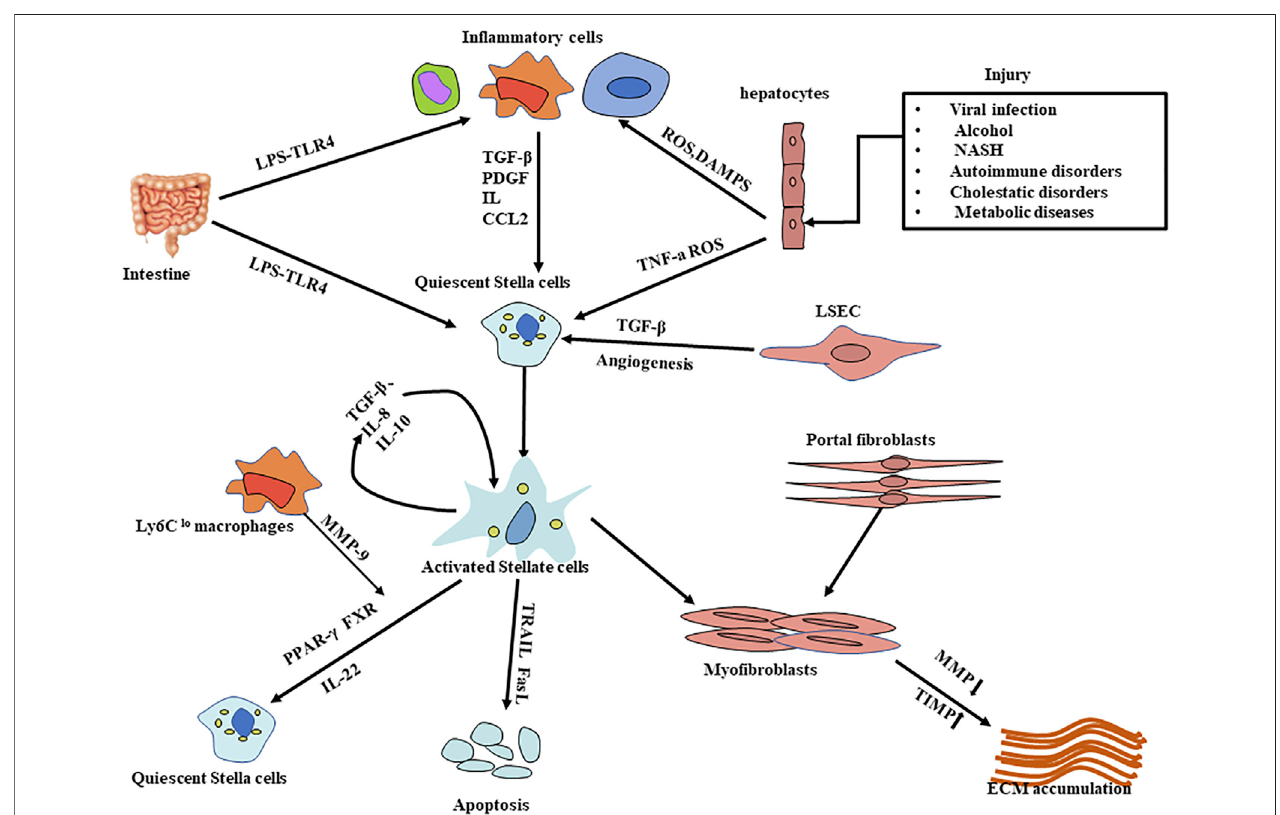
FIGURE1| Mechanismsofliver fi brosis.LiverinjuryiscausedbyavarietyofstimulithatresultinhepatocytedamageandthereleaseofsubstancessuchasROS;in response to persistent hepatocyte injury, HSCs and macrophages (including Kupffer cells) are activated, activated myo fi broblasts increase and excessive ECM is produced, leading to the progression of liver fi brosis. The activation of hepatic stellate cells is a key step in the process of liver fi brosis. Many in fl uential factors regulating HSC activation, proliferation, function, and survival have emerged as important therapeutic targets; likewise, protection of hepatocytes from damage and degradation of excessive ECM deposition provide therapeutic options. HSCs: Hepatic stellate cells CCL2:C-C chemokine ligands types 2; LPS: Lipopolysaccharide LSEC ： Liver sinusoidal endothelial cells TIMP: inhibitors of matrix metalloproteinase; MMP: matrix metalloproteinase; DAMPS:damage-associated molecular patterns; ECM: extracellular matrix; ROS: reactive oxygen